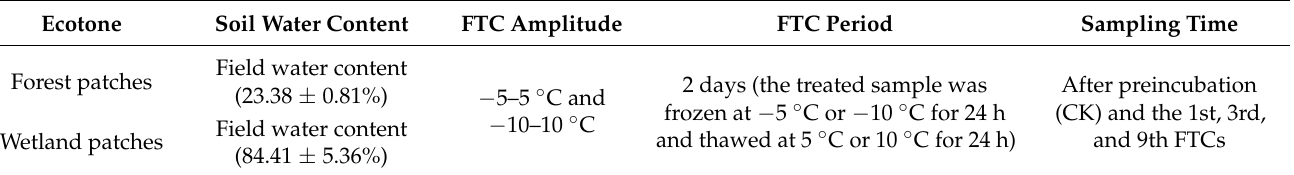
Table 1. Details of the FTC simulation